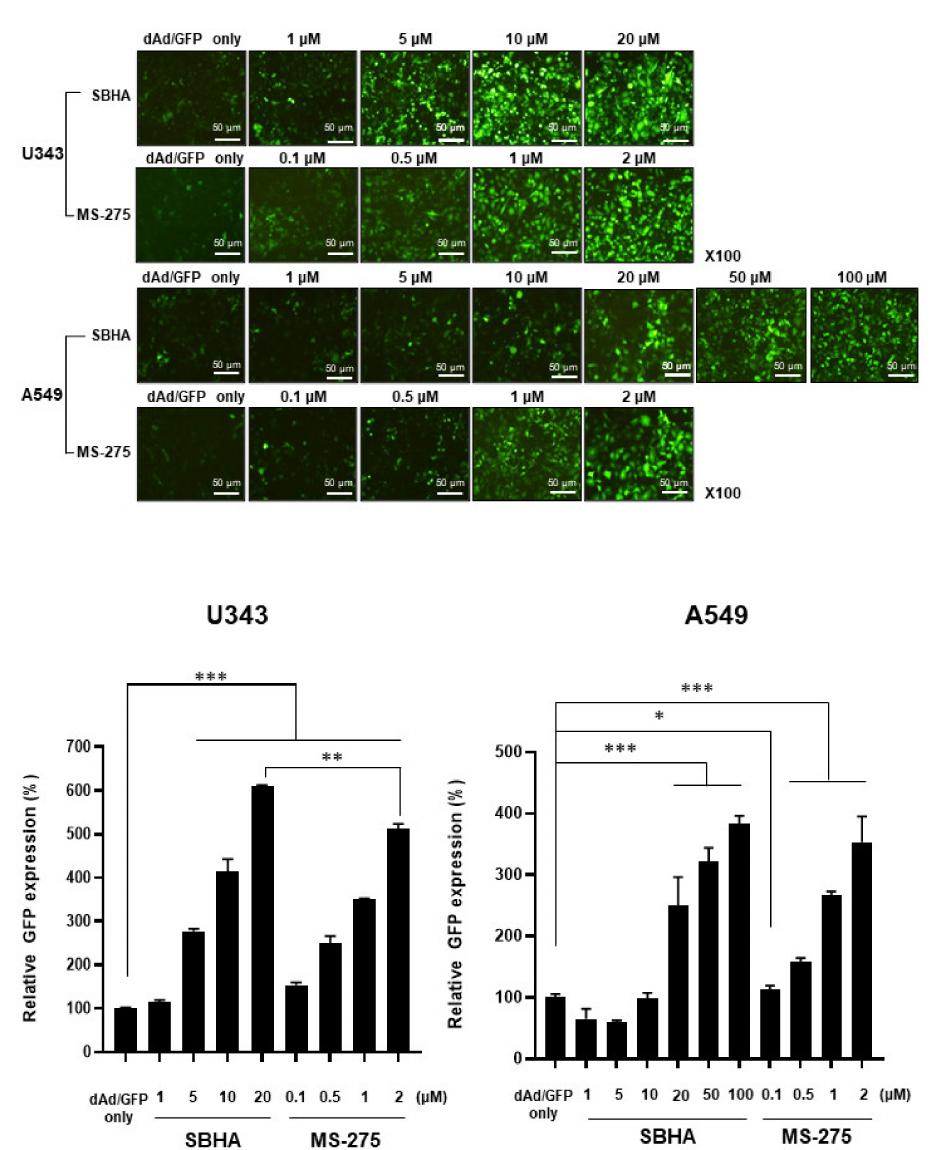
Figure 1. Transduction efficiency of dAd/GFP in combination with HDACi. U343 and A549 cells were pre-treated with SBHA (1–20 µ M for U343, 1–100 µ M for A549), MS-275 (0.1–2 µ M), or PBS for 24 h then transduced with dAd/GFP. At 48 h post transduction, cells were analyzed for GFP expression using the IncuCyte ® Live-Cell Analysis System. Representative imaging results are shown. The data are representative of three independent experiments performed in triplicate. Bars represent the mean ± SD. Original magnification: × 100. The scale bar represents 50 µ m. * P < 0.05, ** P < 0.01, *** P <